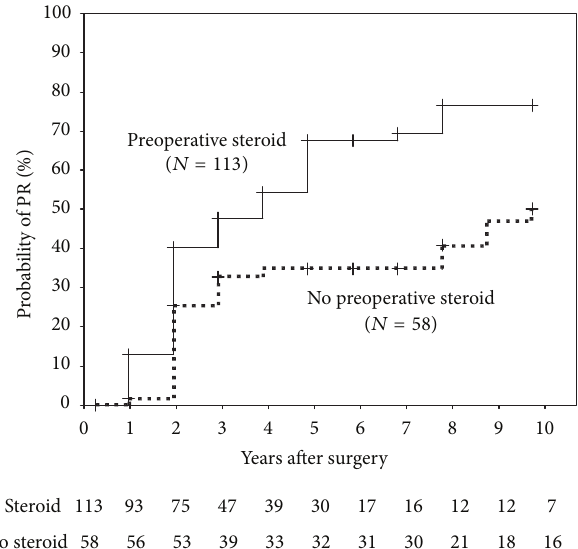
Figure 2: Kaplan-Meier curves for the modified PR in MG patients: Kaplan-Meier curves for MG patients ( 𝑁 = 113 ) in preoperative programmed high-dose steroid treatment group (solid line) versus those ( 𝑁 = 58 ) in no preoperative steroid treatment group (broken line). The modified PR was defined as the absence of symptoms and signs of MG for at least 1 year, with intake of a daily PSL dose of 5.0 mg or less for MG and no intake of other immunosuppressive drugs. Vertical bars indicate censured data. A significant difference was found between the two curves (log-rank test, 𝑃 < 0.01 ). Therefore the present study aimed to clarify the clinical benefits of preoperative programmed high-dose steroid treatment for MG by comparing the long-term outcomes of MG patients who received high-dose steroid treatment prior to thymectomy with those of MG patients who did